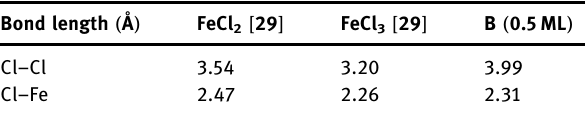
Table 3: Nearest atomic distances ( in Å ) for the optimized bulk